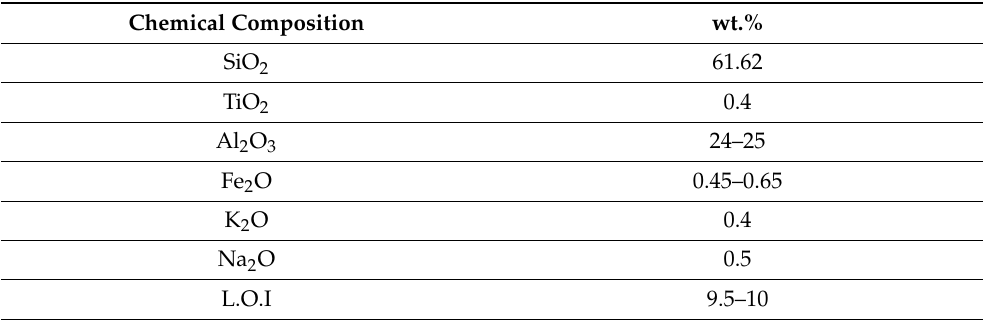
Table 1. Chemical composition (wt.%) of kaolin.